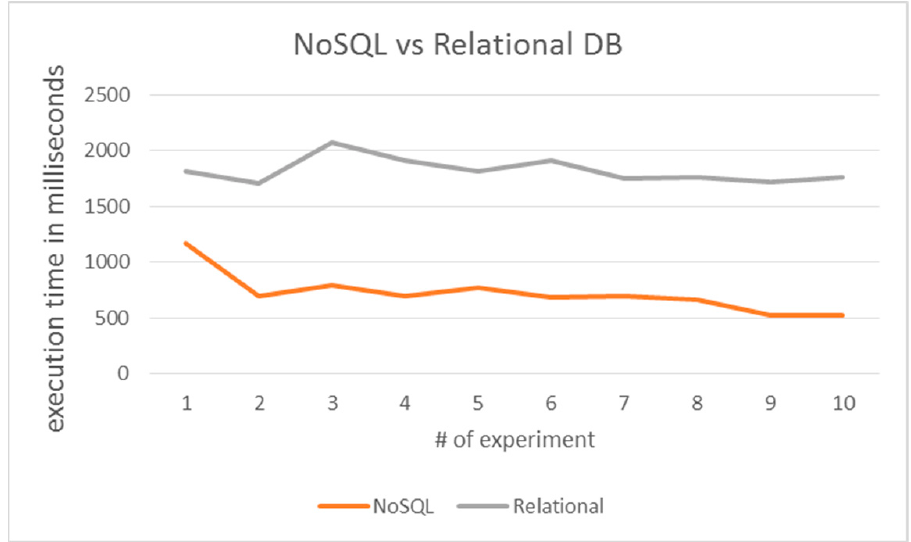
Figure 8. Comparison of NoSQL vs. Relational database query execution.